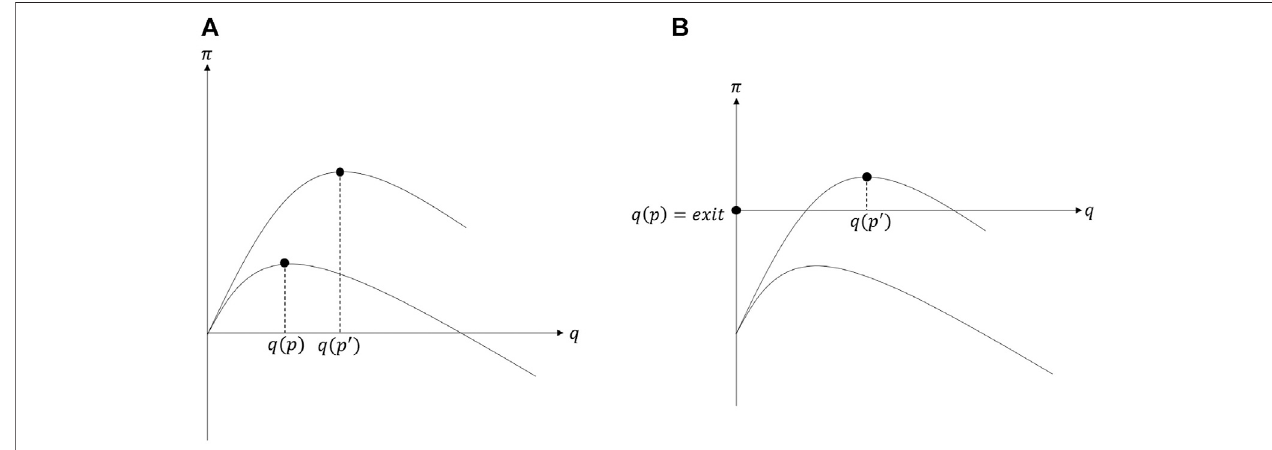
FIGURE 4 | (A) Ef fi ciency effect (B) Entrance